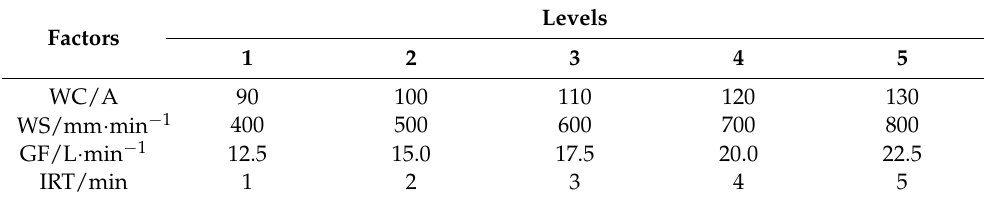
Table 2. Range of matrix building parameters with four factors and five levels.